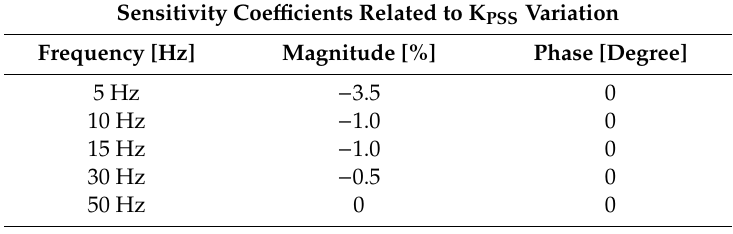
Table 4. TG unit controller’s sensitivity coe ffi